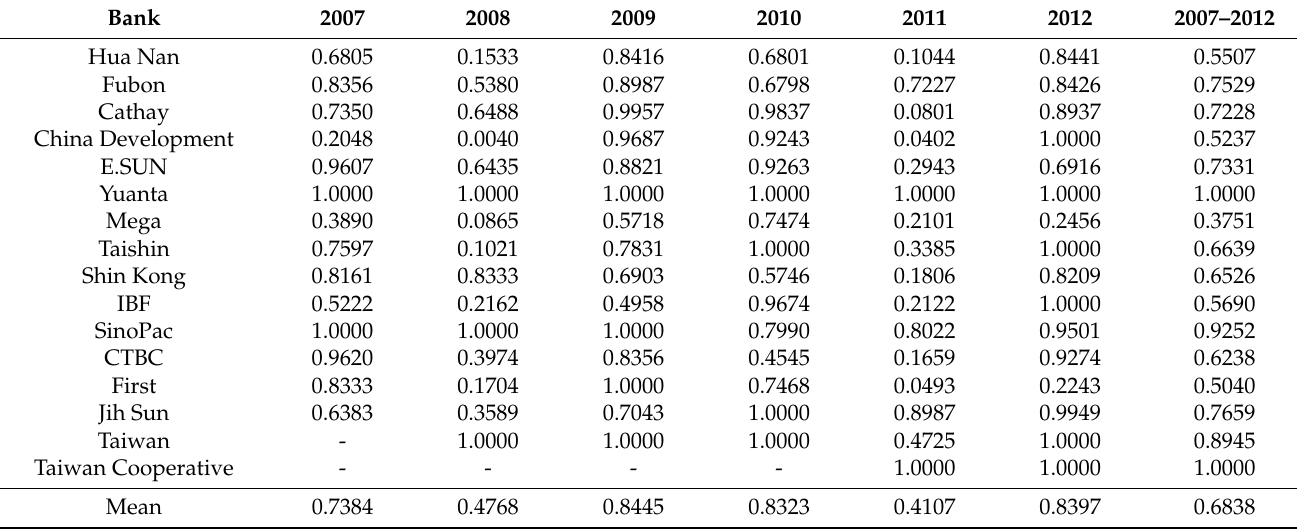
Table 9. Profitability performance for securities service of Taiwanese FHCs in Model